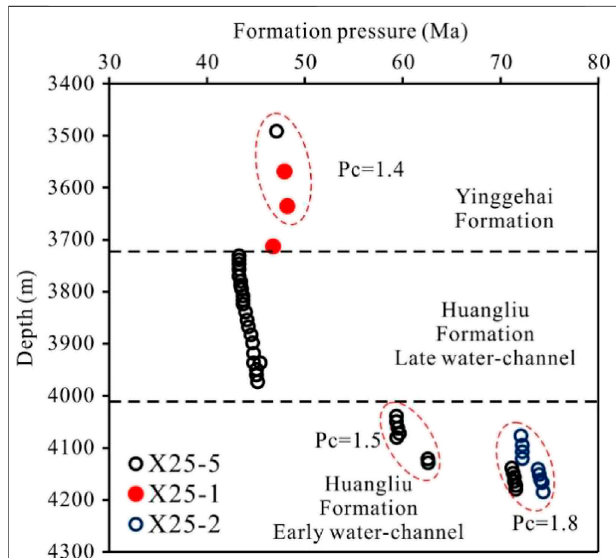
FIGURE 7 | Pressure distribution of LS25 gas fi elds in the Lingshui Sag (Li et al., 2021).